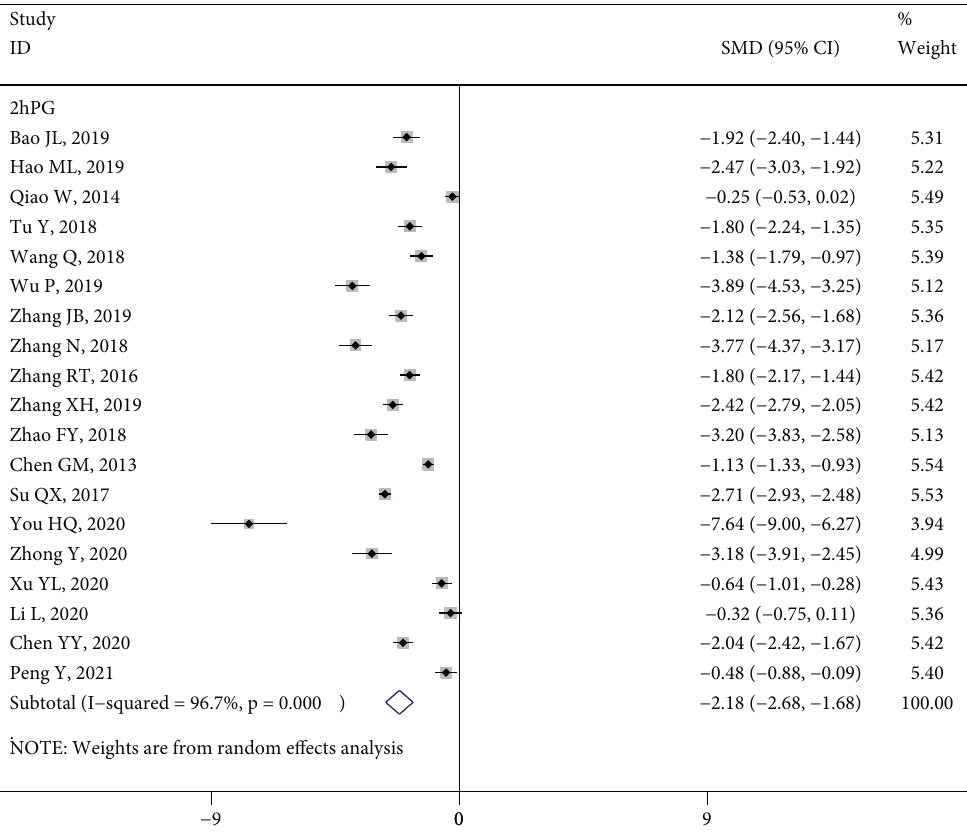
Figure 3: Forest plot of the e ff ect of health literacy intervention on